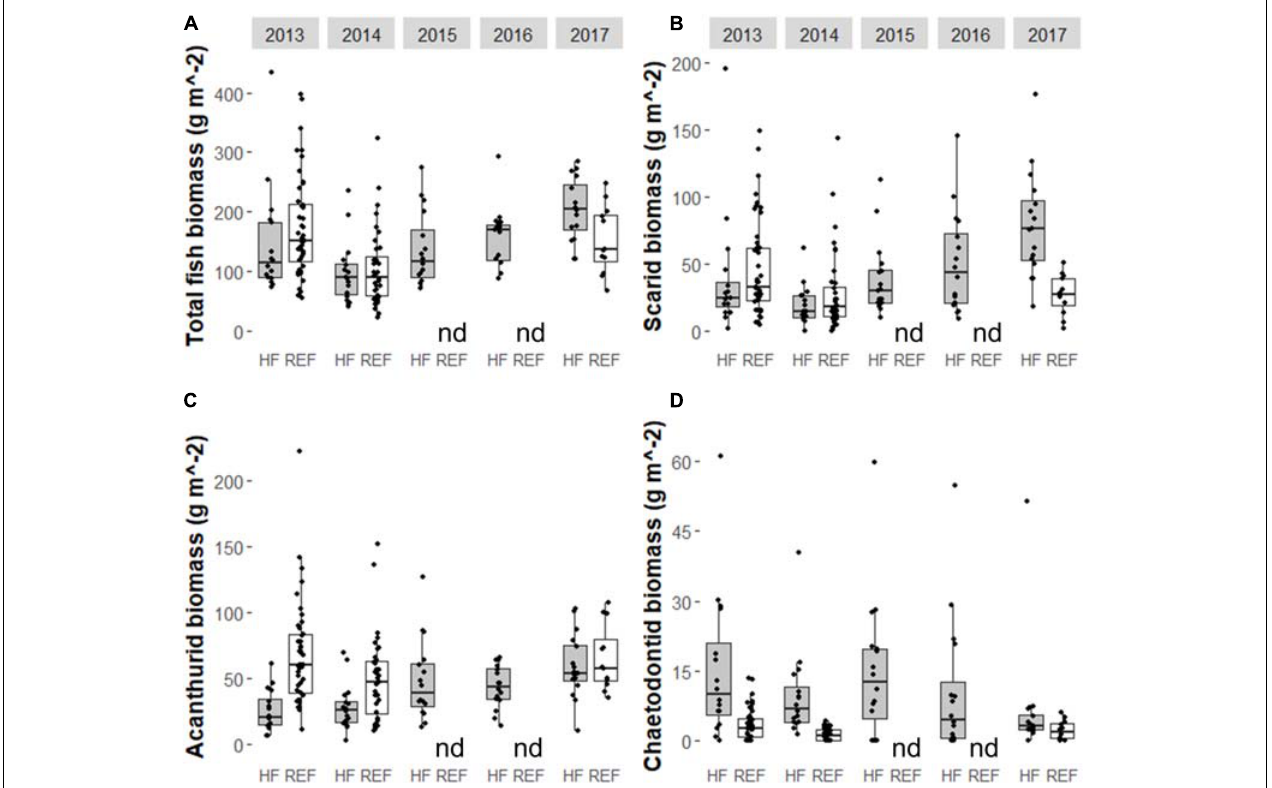
FIGURE 4 | Box and whiskers plot of the biomass of (A) all fishes (excluding sharks and jacks), (B) scarids, (C) acanthurids, and (D) chaetodontids on transects surrounding the site of the Hui Feng shipwreck (shown in gray and noted on the x -axis with ‘HF’) and at reference sites (shown in white and noted on the x -axis with ‘REF’) on the reef terrace and backreef at Palmyra Atoll from 2013 to 2017. Note that y -axis varies between panels. Reference sites were not surveyed in 2015 or 2016 (no data indicated by ‘nd’). The wreck was removed between the 2013 and 2014 surveys.